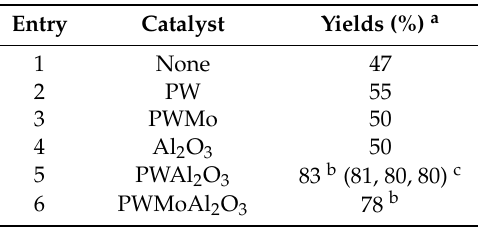
Table 7. Effect of different catalysts on product yields (%). Reaction conditions: 4-toluidine (1 mmol); acetonylacetone (1 mmol); catalyst (4 mg of active phase); solvent-free; temperature, 60 °C; time 45 min; stirring.